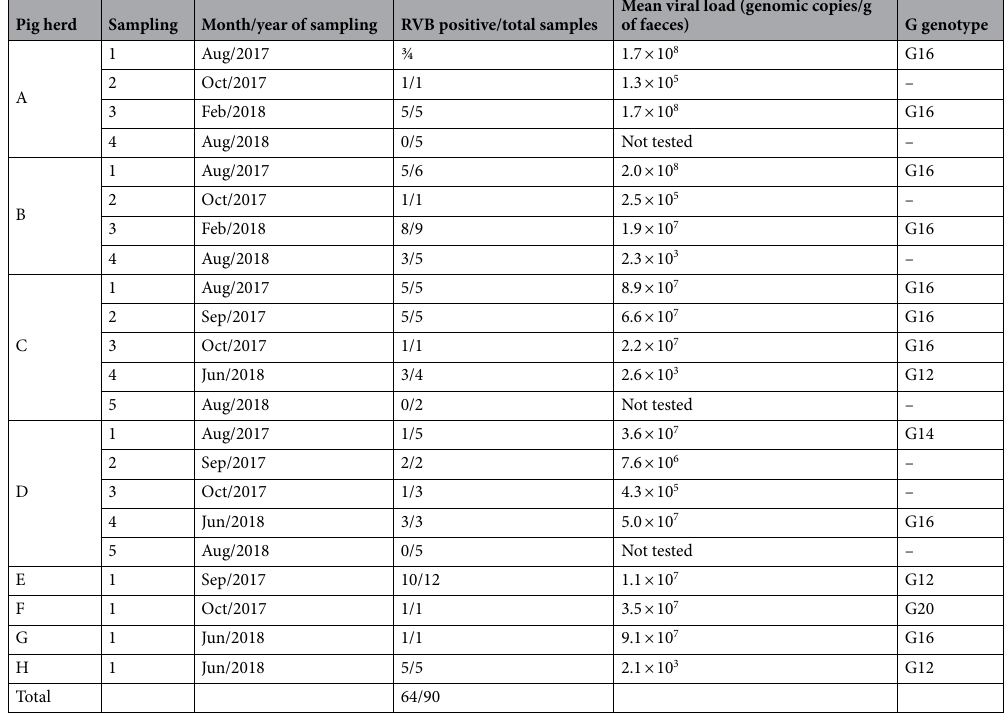
Table 1. Distribution of total biological samples positives for RVB and respective viral load and G genotypes identified by pig herds and